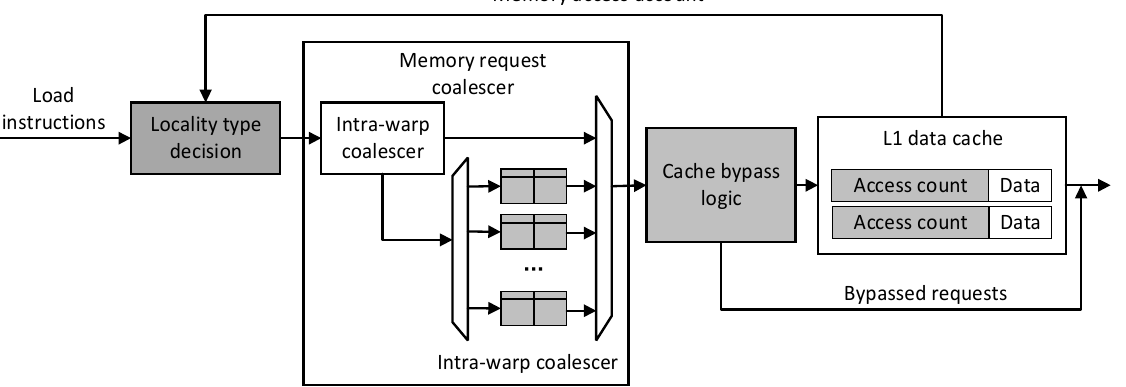
Figure 4. Overall diagram of Locality-Based Cache Management architecture.